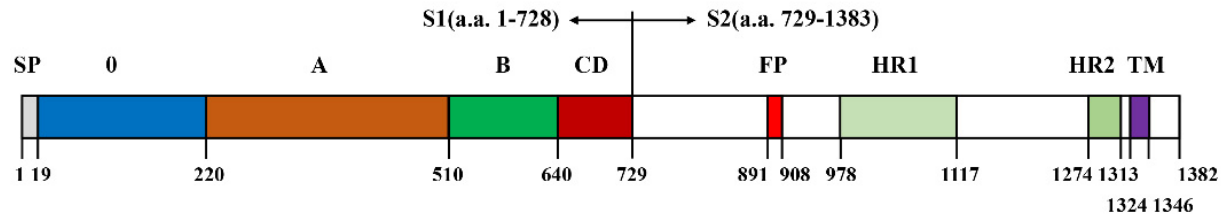
Figure 1. Schematic diagram of porcine epidemic diarrhea virus (PEDV) spike (S) protein. Different domains of S protein of PEDV CV777 (S CV777 ) (ALS35469.1) are colored. SP, signal peptide; 0, S1 0 ; A, S1 A ; B, S1 B ; CD, S1 CD ; FP, fusion peptide; HR1, heptapeptide repeat 1; HR2, heptapeptide repeat 2; and TM, transmembrane domain. Numbers shown below the long bar denote the beginning and end amino acids of each domain.